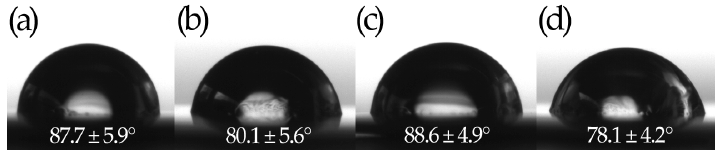
Figure 3. Water contact angles of ( a ) Au-PDMS/Chi-77KS [35], ( b ) Au-PDMS/Chi-77KS/HA, ( c ) Au- PDMS/Chi-77KS/AMOX [35] and ( d ) Au-PDMS/Chi-77KS/HA/AMOX/HA.